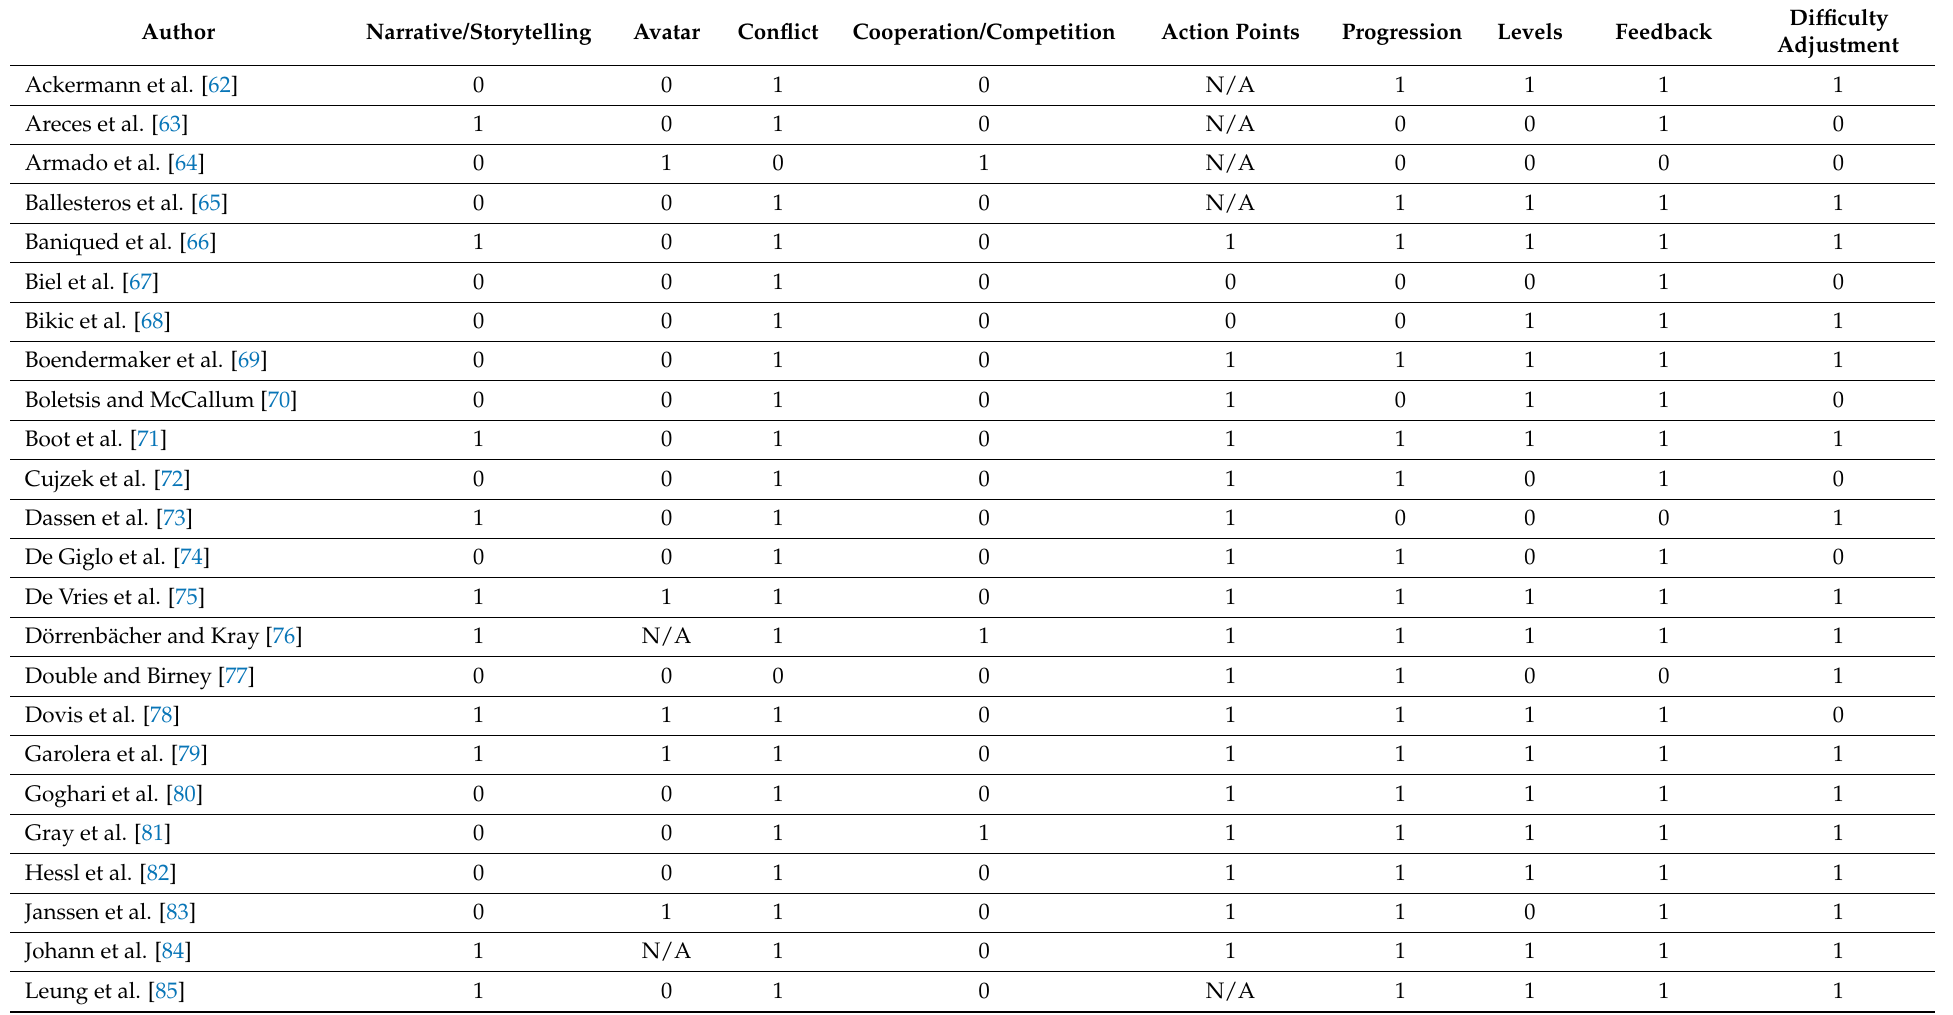
Table A2. Game elements used in the studies of the systematic